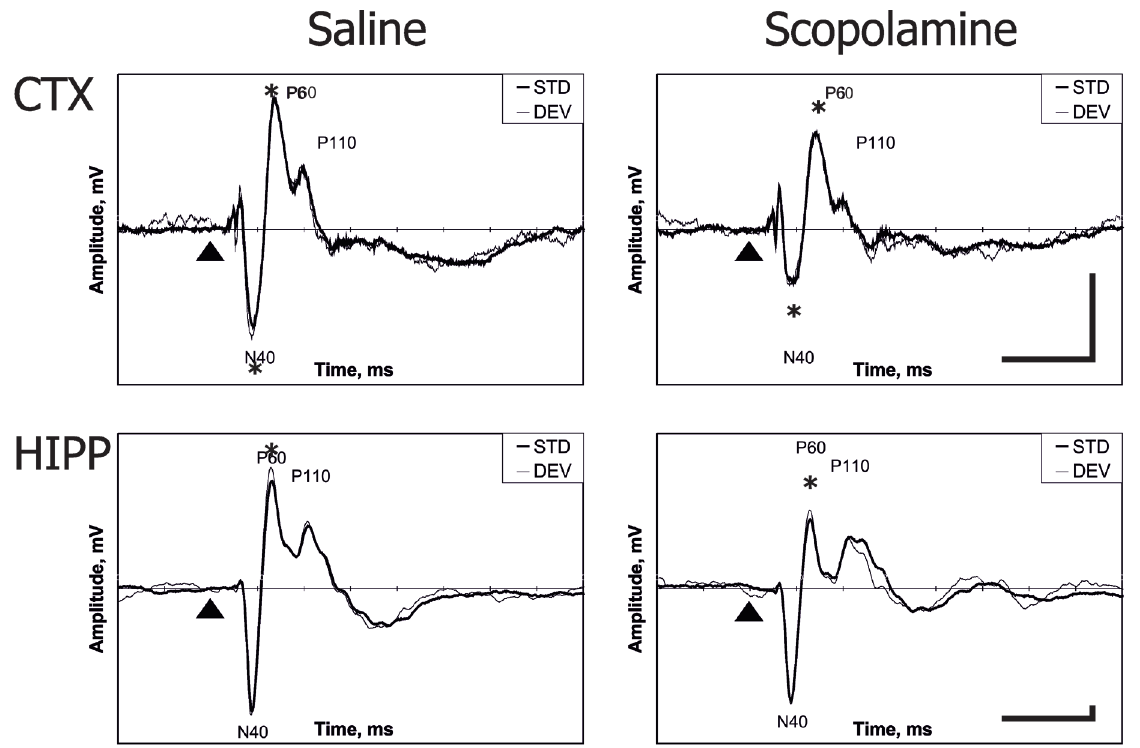
Figure 4. Scopolamine effect on cortical and hippocampus AEPs. Representative example obtained from one rat in the auditory oddball paradigm. The thin line indicates the response to the deviant tone and the thick line the response to the standard tone. The triangle marks the tone onset. Horizontal bar corresponds to 100 ms, vertical bar to 0.04 mV (cortical scale is 5.7 times smaller than that for the hippocampus). Negativity is downward. * significant difference between scopolamine and saline